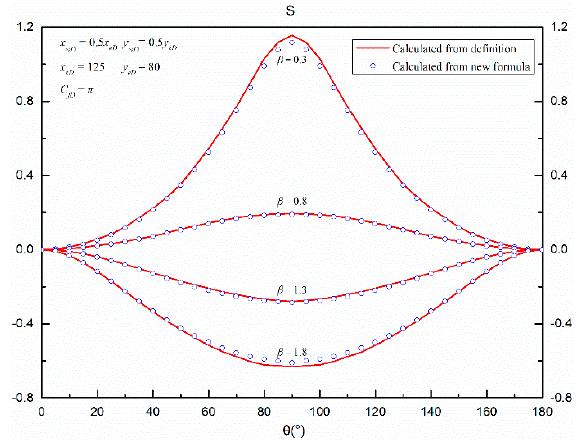
Figure 11. Comparison of pseudo-skin factors calculated from definition and new formula.